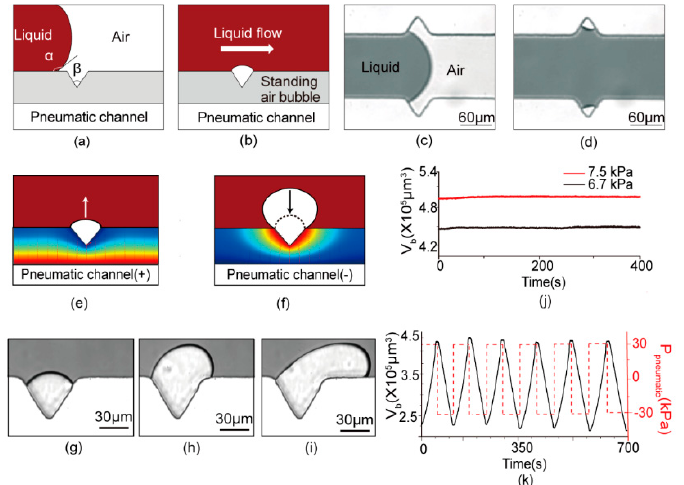
Figure 2. Generation and variation mechanism of the micro standing air bubble. ( a , b ) Schematic of a typical standing air bubble generation structure. ( c , d ) The microscopic observation of the bubble formation process. ( e , f ) Microfluidic standing air bubble ( µ SAB) volumetric variation principle, based on the ideal gas law, where the air di ff usion leads to the µ SAB volumetric enlargement / shrinkage under positive / negative pressure. ( g – i ) Top view of the bubble volume change process under a microscope. ( j ) The stability of the controllable standing air bubble under 5 µ L / min flow rate at 7.5 kPa and 6.7